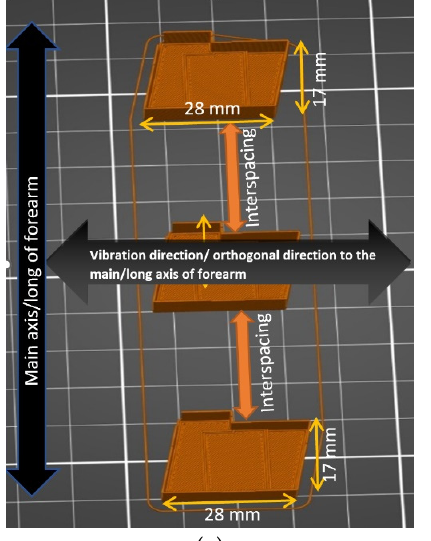
Figure 1. ( a ) Technical and dimensional information for the L5 voice coil actuator, and ( b ) the voice coil actuator (Model: Lofelt L5) used in this study [35].